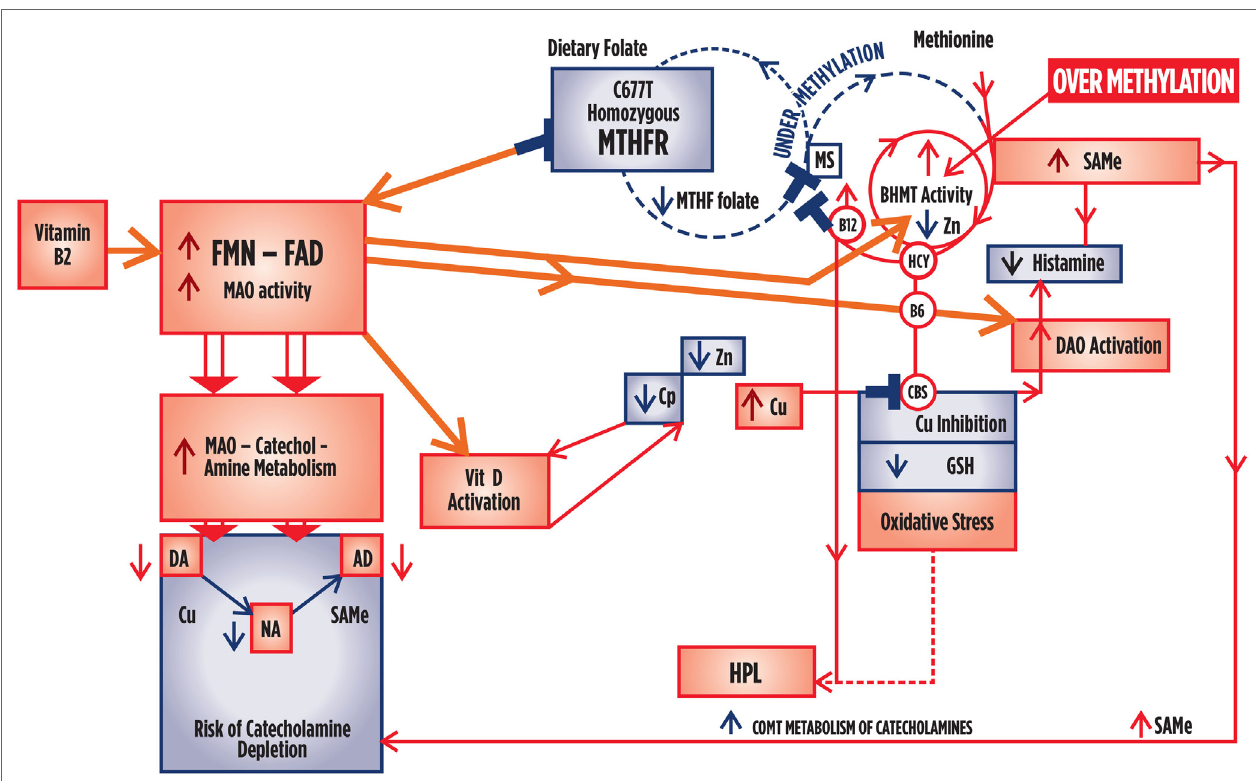
FigUre 4 | summary outcome when there is a homozygous 677TT polymorphism governing low activity of the MThFr enzyme, but where folate and flavin availability in the presence of normal hormonal conditions and sufficient sources of flavins and folate from dietary and gastrointestinal sources . Where significance index [SI] = [(1 − P -value) × 1000], caseness for psychosis is only marginally related to HPL/Creatinine [SI = 33]. Caseness was also marginally related to Free Cu/Zn ratio [SI = 33], where Free Cu/Zn also relates to GAF [SI = 43] and CGI [SI = 30]. Catecholamine held no significant correlates within this data set. Levels of folate are low in relationship to high homocysteine [SI = 84], and B12 [SI = 45] and high homocysteine levels correlate with low B6 levels